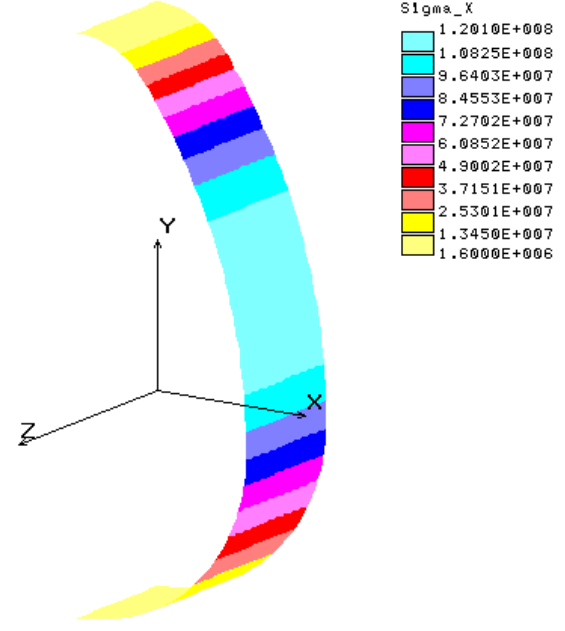
13.4 MPa < s / g = 300/2 = 150 MPa. The normal stresses are bZ